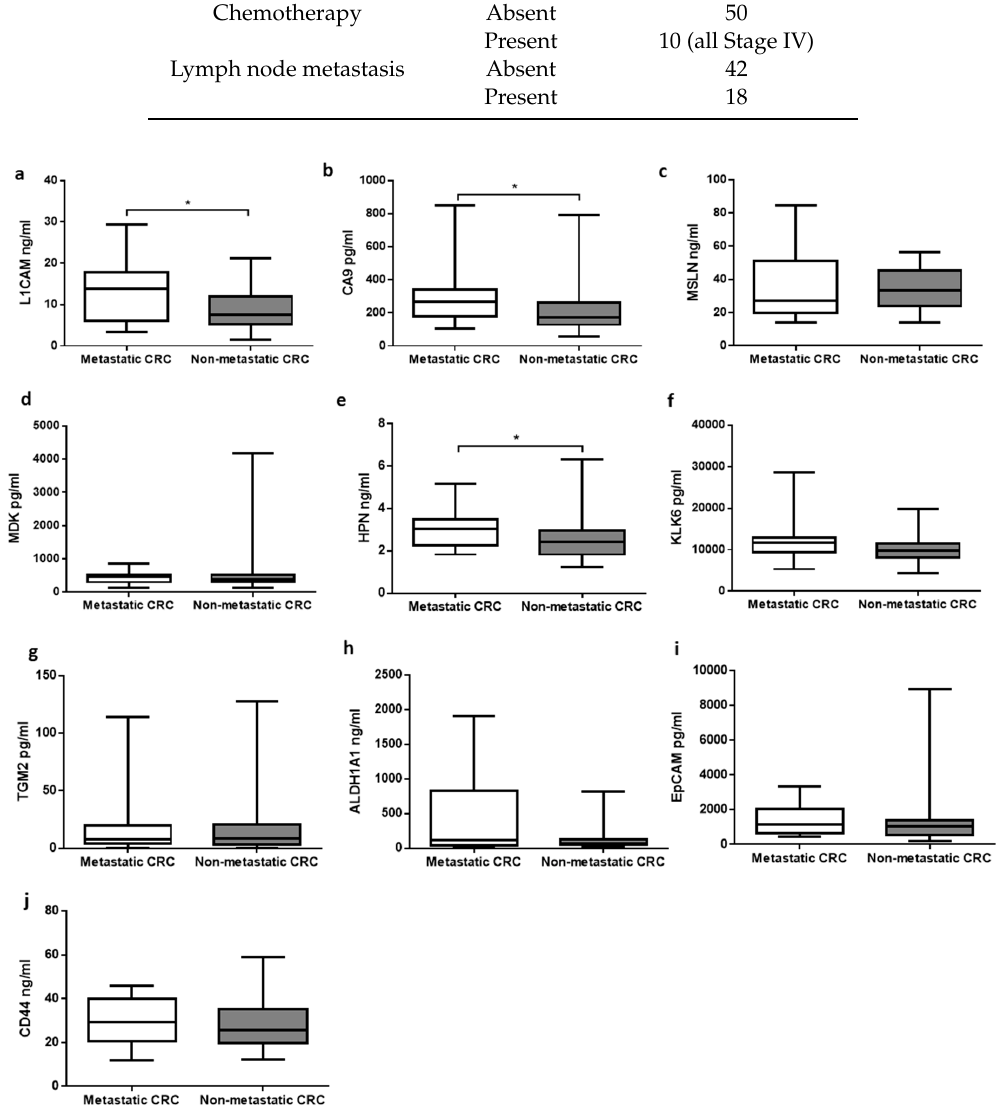
Figure 1. Comparisons of concentrations of biomarkers in serum between primary and mCRC. ( a